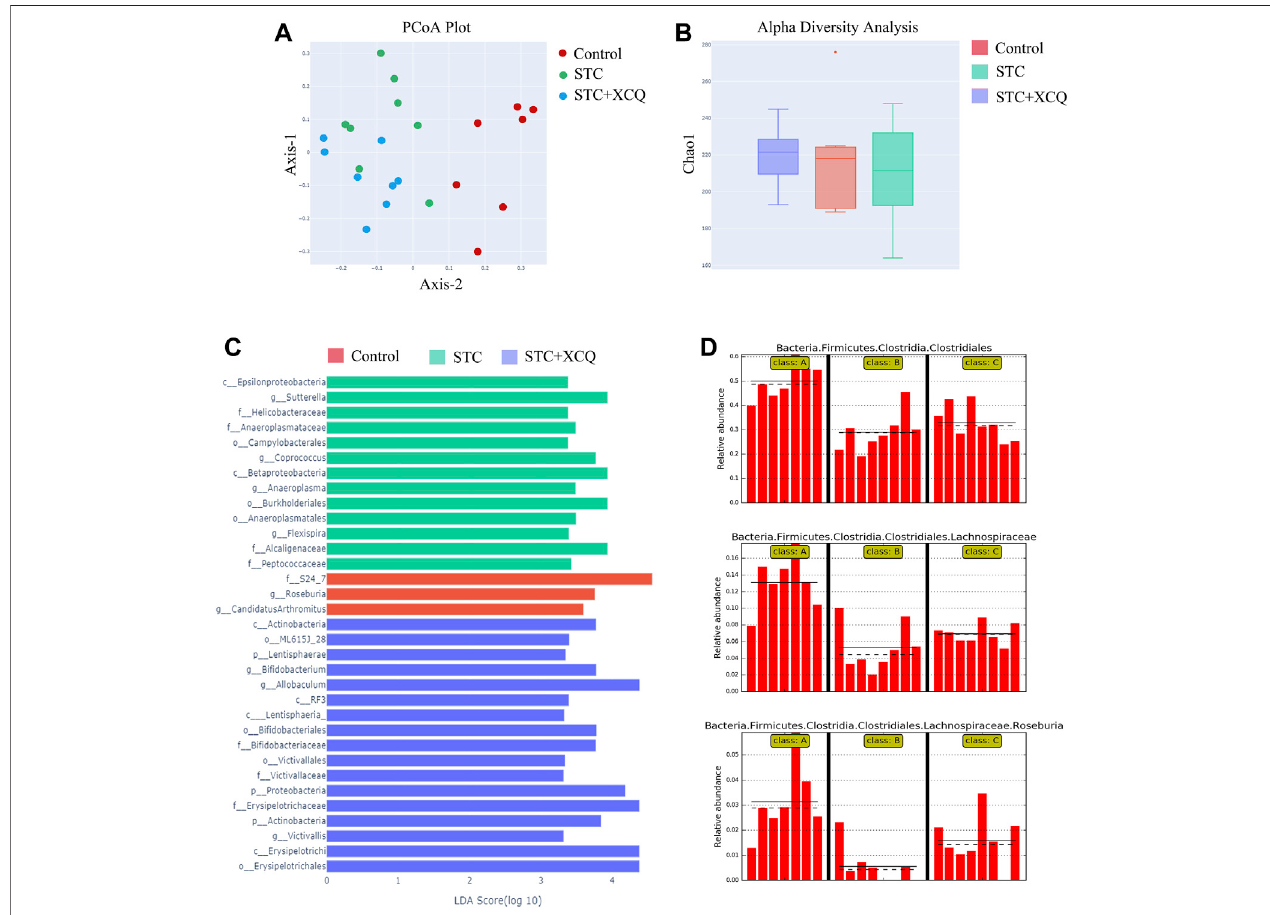
FIGURE 3 | The effect of Xiao Chengqi formula on intestinal fl ora of slow transit constipation (STC) rats. (A) PCoA scatter plot showed that there were signi fi cant differences in intestinal fl ora abundance among the three groups, and the fl ora abundance of the STC group was signi fi cantly lower than that of the control group; (B) Chao1index showed thattherewasnosigni fi cantdifference incommunity richness among thefecesofratsintheblankgroup, STC group,and experimental group; (C) LEfSeanalysisshowedthat Roseburia spp.weretherepresentativebacteriawithsigni fi cantdifferencesamongthethreegroups; (D) Basedontheorder,familyand species levels, it can be seen that the abundance of Roseburia spp. in the STC group decreased signi fi cantly, and the abundance increased signi fi cantly after XCQ treatment.